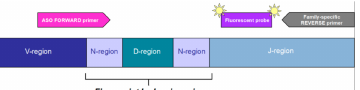
Figure 2. Leukemia specific assay design. An allele-specific oligonucleotide (ASO) primer is designed on the N-region between the V/D or D/J gene junction and used in combination with a family- specific primer and fluorescent probe. The fluorescence emission detected by the instrument is directly proportional to the amount of target DNA in the